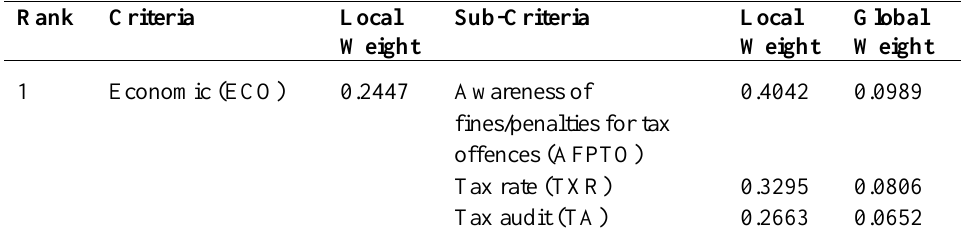
Table 7: Combined Final Combinations of Weights and Priority Vectors of Criteria towards the Assessment of Tax Avoidance and